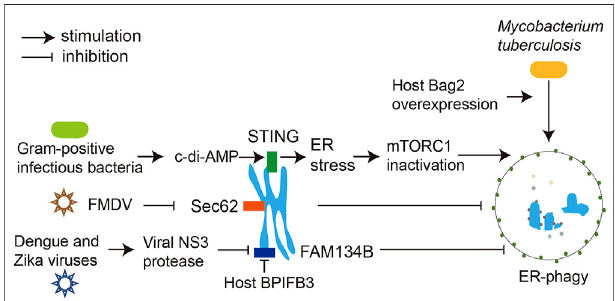
FIGURE 2 | Interaction of pathogenic microorganisms with ER-phagy. DENVs and ZIKVs inhibit FAM134B-mediated ER-phagy through their NS3 protease, preventing ER autophagic degradation and thus ensuring the availability of synthetic building blocks from the ER necessary for their replication.HostBPIFB3inhibitsFAM134B-dependentER-phagyin fl avivirus- infected cells. For FMDVs, their infection inhibits Sec62-mediated ER-phagy. When Gram-positive bacteria infect cells, the c-di-AMP produced activates the ER-localized immune sensor STING, which subsequently inhibits mTORC1andinitiatesER-phagyto fi ghttheinfection.Ofnote,overexpression of host factor Bag2 in the Mycobacterium tuberculosis- infected murine macrophages induces ER-phagy.